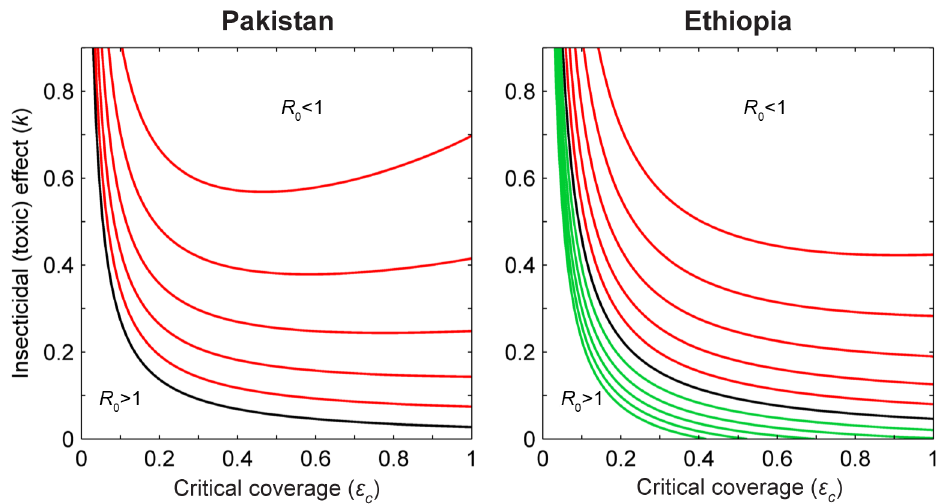
Figure 6. Critical proportion of ITL as a function of the insecticidal ( k ), and diversionnary effect ( a ). The lines show the combination of values of coverage and insecticidal probability required to achieve R 0 =1, above which R 0 will be decreased below 1, for a given diversion probability ( a ). Black line: a ~ 0 , no repellency or attractancy (is the same as the white line in Figure 4); Red lines: a w 0 , repellency increasing from 0.1 to 0.5 (top), at intervals of 0.1; Green lines: a v 0 , attractancy increasing from 2 0.1 to 2 0.5 (bottom), at intervals of 0.1. Other parameters are as in baseline simulations (Table 2).